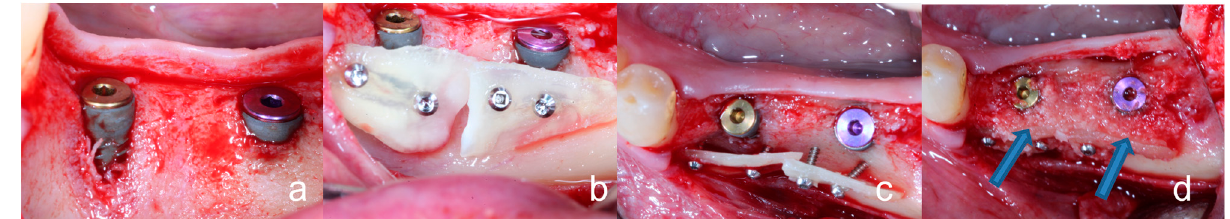
Figure 3. Compilation of the Tooth Shell Technique of a case with an immediately used tooth of another region: ( a ) Lateral view: Implants in region 35 and 36. The lateral defect is visible. ( b , c ) Multilateral view (lateral and occlusal): Two detin shells are stabilized with four osteosynthesis screws on the implants. ( d ) Particulated dentin in the interspace (blue arrows).